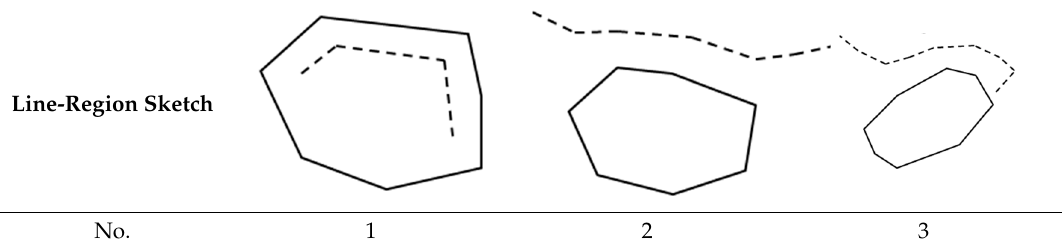
Table 3. Line-region sketches for evaluation of suitability.